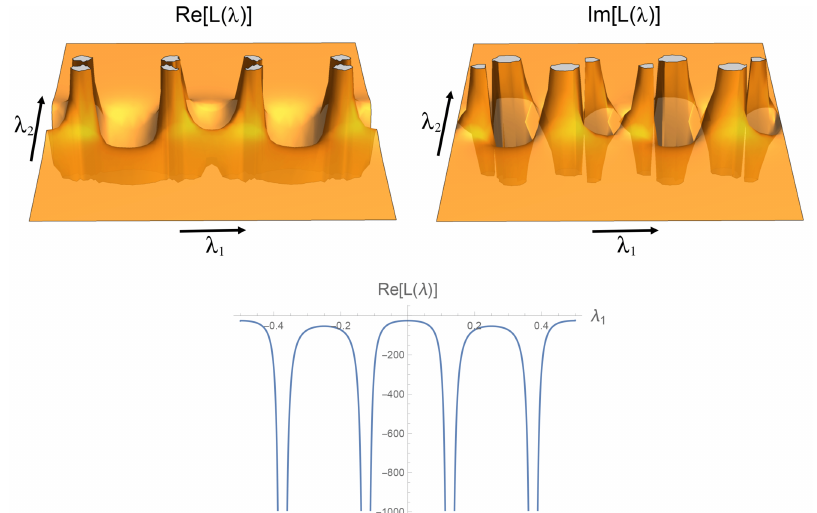
Figure 4 . Top: real (left) and imaginary (right) parts of L ( λ ) — defined in equation (2.8)—in the BTZ phase. The metric (2.7) is singular at the values of λ corresponding to the endpoints of the slits (i.e. λ = 0 and λ = {− L/ 2 + ‘/ 2 , − ‘/ 2 , ‘/ 2 , L/ 2 − ‘/ 2 } , here ‘ = 0 . 25 , L = 1 ) for any value 2 1 of the radial coordinate z , and approaches a constant value away from the λ λ measurement is performed. Bottom: real part of L ( λ ) in the BTZ phase as a function of λ λ 2 = 0 slice. The singularities at the endpoints of the slits are well visible. A similar plot for the thermal AdS phase is reported in figure 27 in appendix B.2. 3